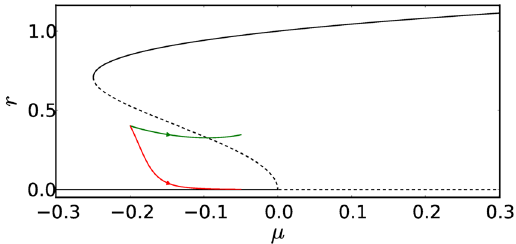
Figure 1. Bifurcation diagram depicting the plot of r as a function of μ for the system given in equation (1) with a = 1 and b = 1. The Hopf bifurcation occurs at μ = 0 and the fold bifurcation occurs at μ = − 0.25. The solid black lines represent stable limit cycle while the dashed black lines represent the unstable limit cycle. The red and green lines denote the trajectory followed by the system (equation 1) for the same initial condition ( r 0 = 0.4, = − 0.2) while the parameter is varied at different rates ( µ =  c ) till μ μ 0 lower than a critical value ( c r = 12.83 × 10 − 3 for this set of parameters), the system decays to the fixed point (red trajectory). The system crosses the unstable limit cycle when the rate of change of parameter µ = .  0 02 is above the critical value (green